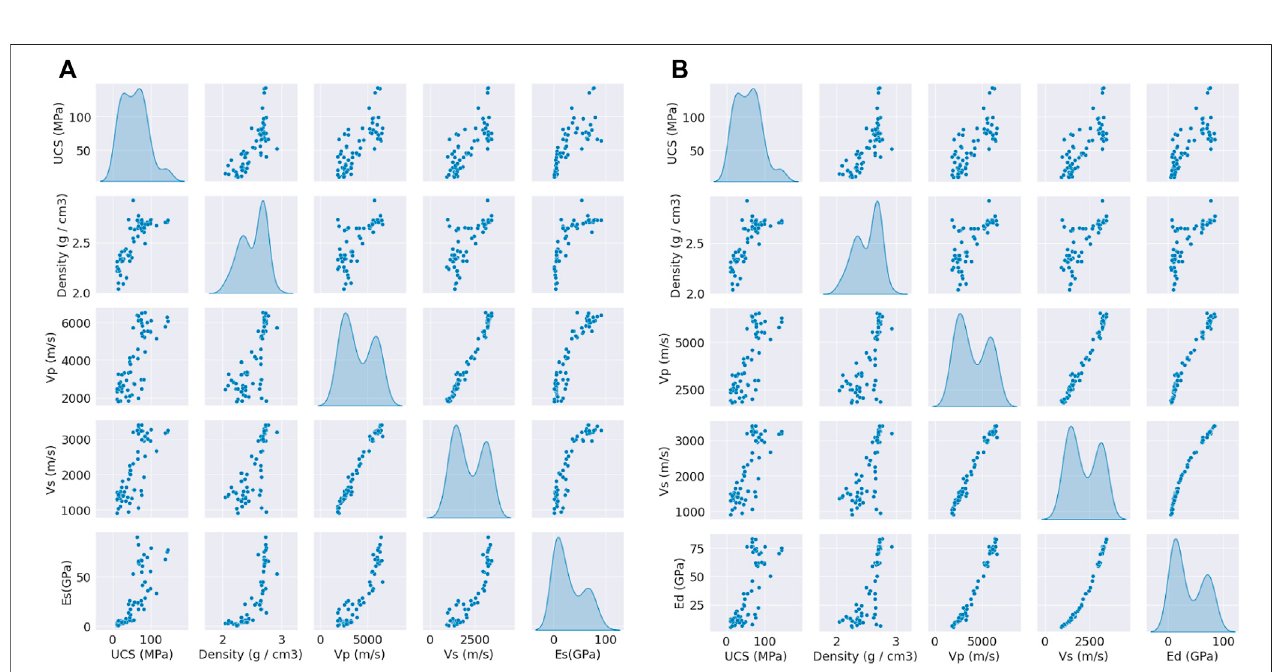
FIGURE 1 | Pairwise relationship of input parameters and outputs (A) E s and (B) E d in the dataset.